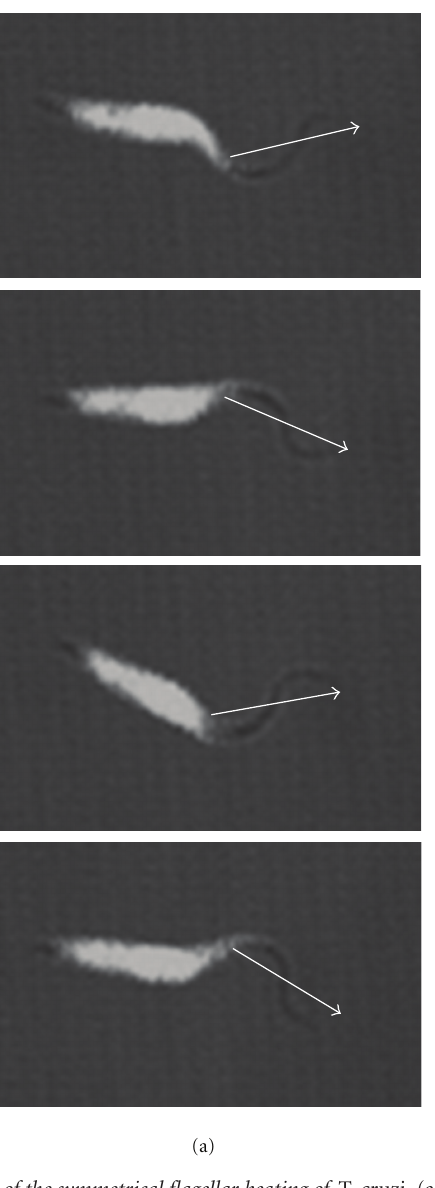
(d) flagellar beating that directs the epimastigote motility; (e) sporadic asymmetric base-to-tip beats that represent a ciliary beat of trypanosomatid flagella and produce a directional drift for the